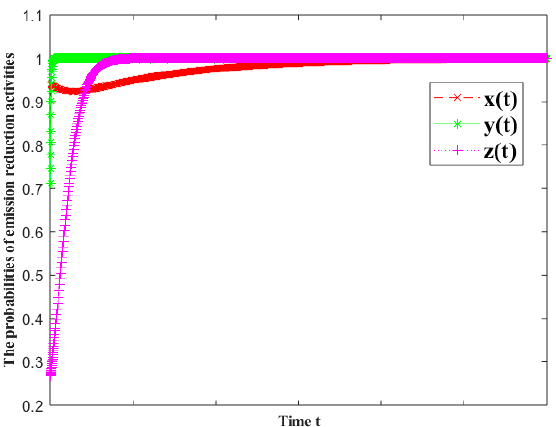
Figure A1. The probabilities of emission reduction activities in the industrial symbiosis system of Baosteel.